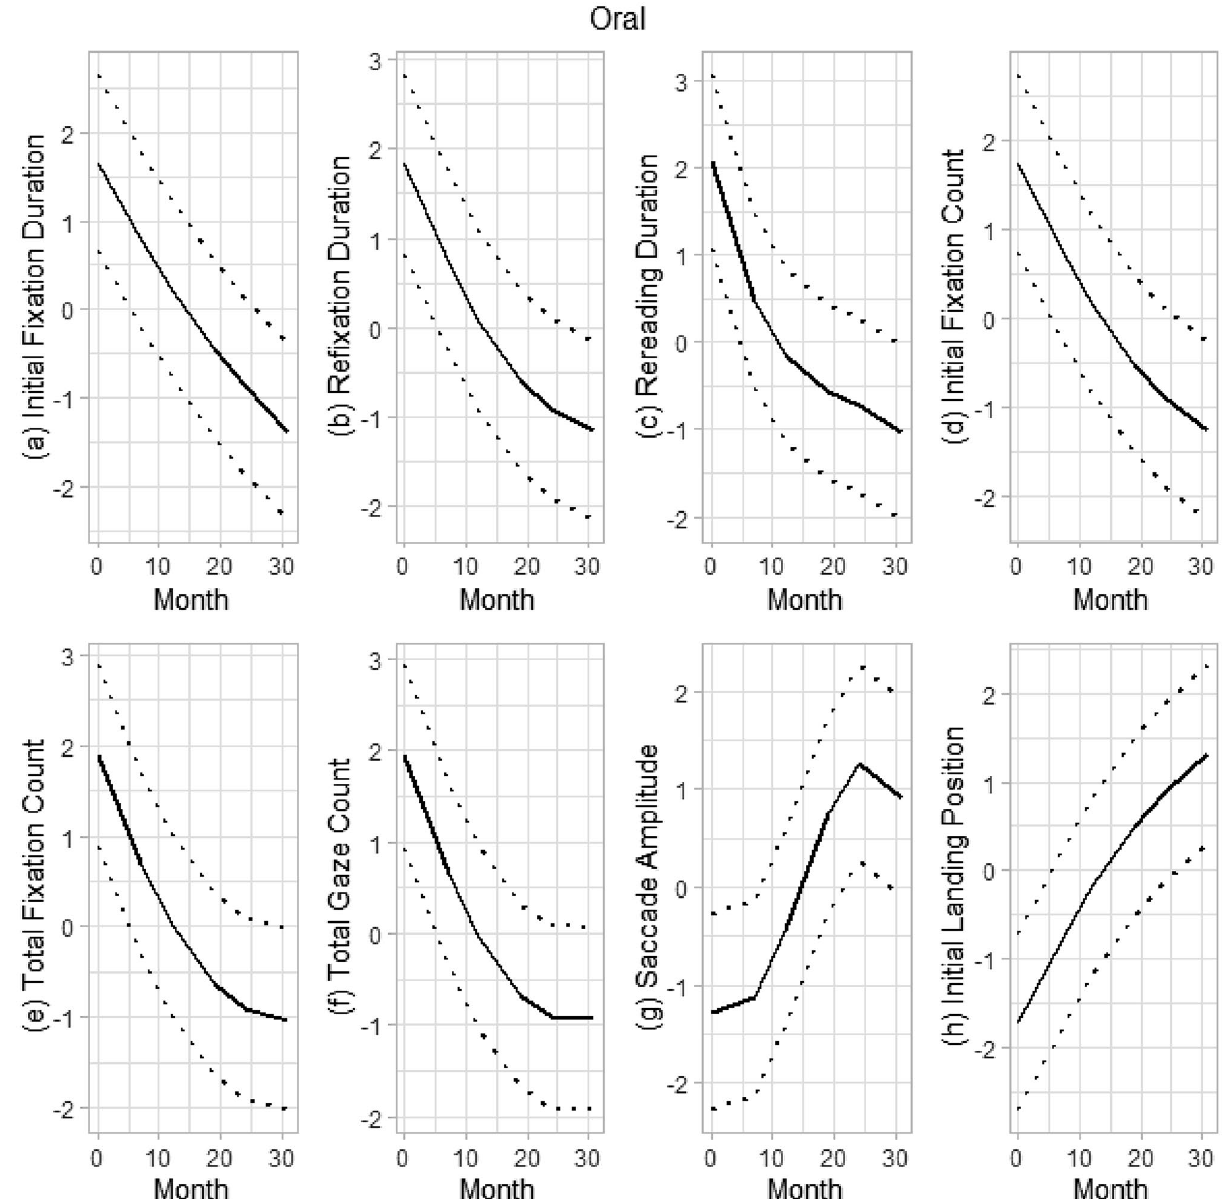
Figure 1. Growth trajectories of eye movements in oral